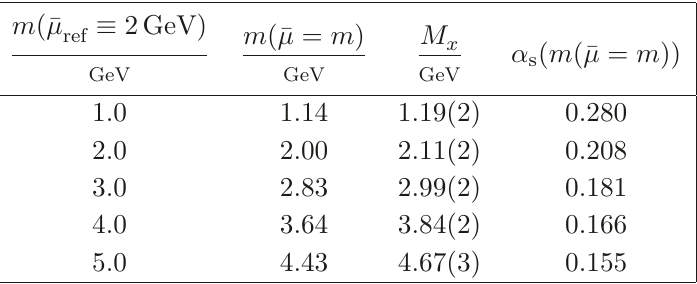
Table 1 . The quark masses used on the perturbative side of this study ( N 5-loop running for the MS mass m [45, 46] and for α s [47, 48]. The pole-like mass M defined through eq. (3.16), with x = 4 . . . 8 yielding the variation shown. For scale setting we use r Λ = 0 . 602(48) [49] and r 0 MS r Λ = 0 . 593(17) [51]). A potential model suggests that m (¯ µ 0 MS relevant for the charmonium case, M to the value relevant for the bottomonium case, M subject to large